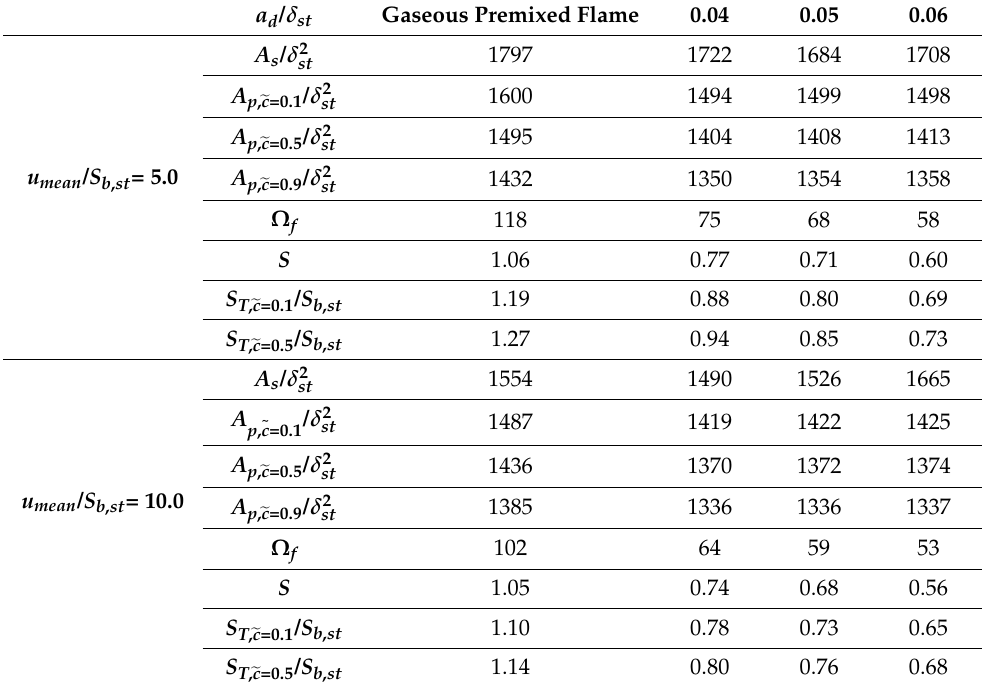
Table 3. Time averaged normalised values of A s = (cid:82) . w c dV / [ ρ 0 S b , st S = V